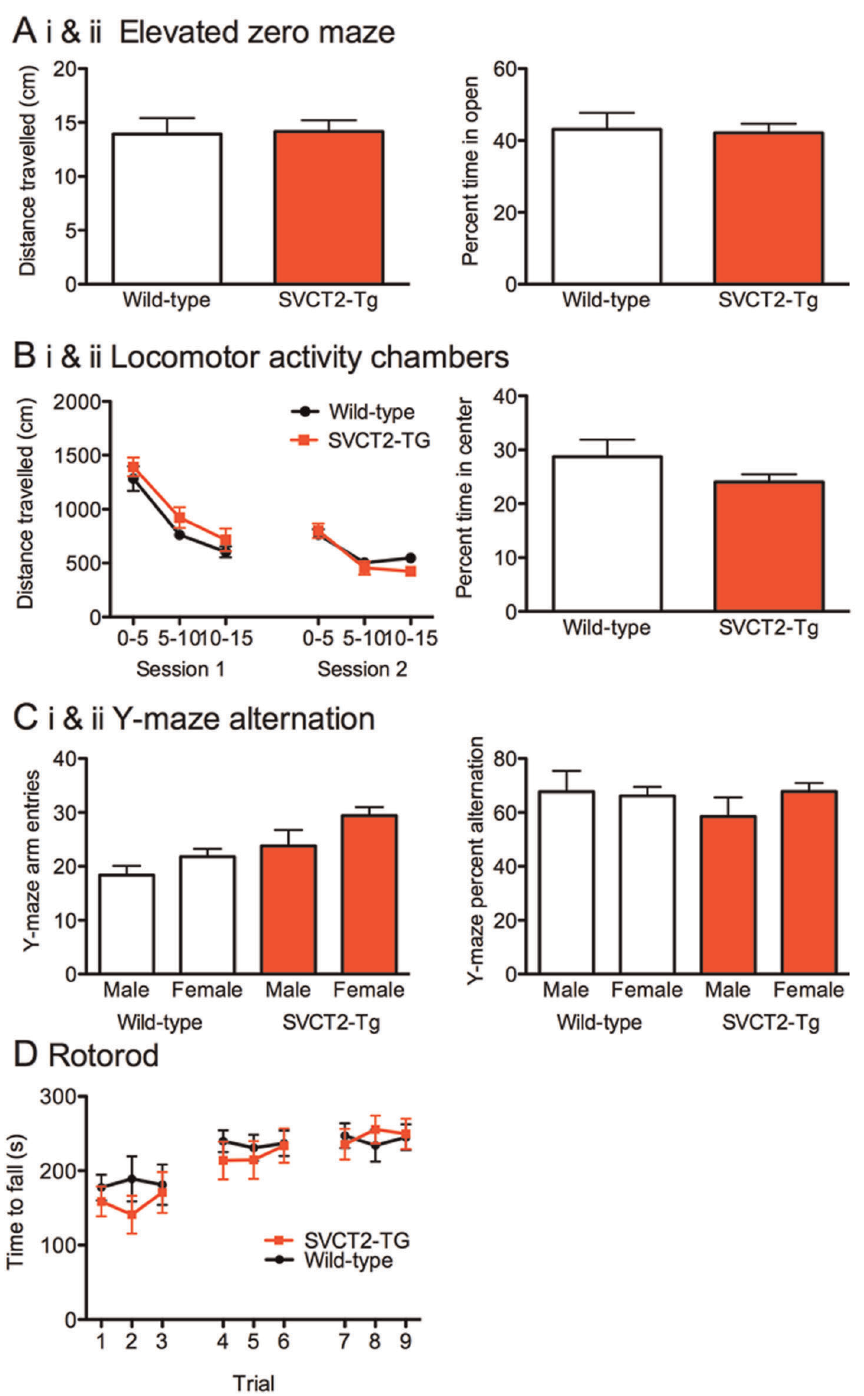
Figure 6. Normal behavior in SVCT2-Tg mice. Wild-type (white bars, black circles) and SVCT2-Tg mice (red bars, red squares) did not differ on any of the behavioral measures conducted. (A) Elevated zero maze for (Ai) distance travelled and (Aii) percent time in open zones, (B) locomotor activity (Bi) time traveled during two 15-min. sessions, and (Bii) time spent in the central portion of the maze during the first 5-min., (Ci) entries and (Cii) alternation in the Y-maze, and (D) time taken to fall or rotate on the rotorod. Data shown are mean + S.E.M. N=10 mice per group.